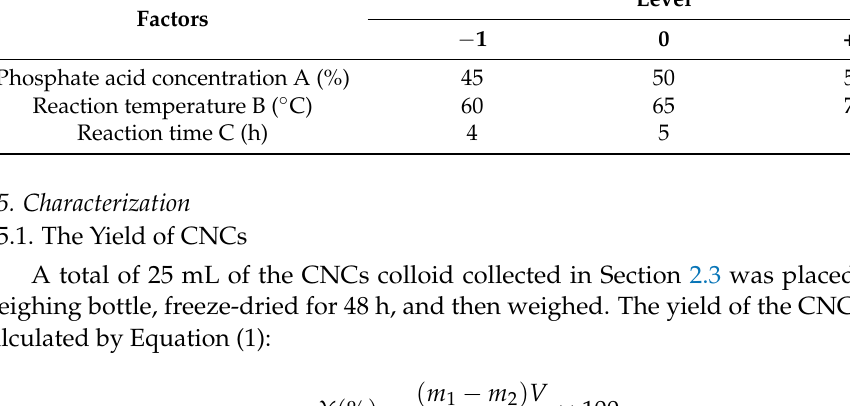
Table 1. Levels of the factors chosen for the trials. Factors Phosphate acid concentration A